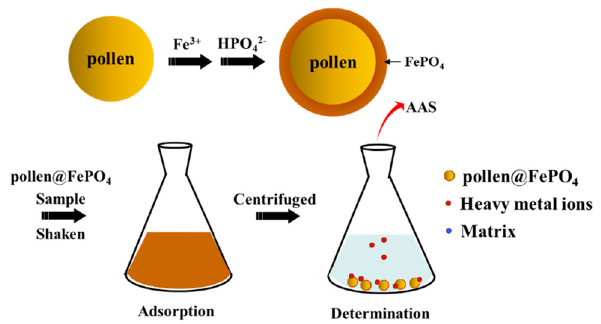
Figure 1: Preparation of pollen@FePO 4 and sorption of heavy metals on pollen@FePO 4 .